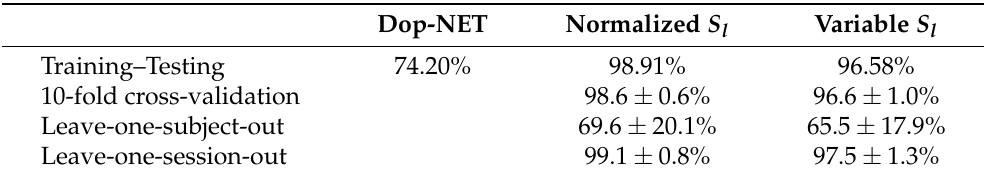
Table 3. Dop-NET results for an LSM with 960 neurons and C inp = 5, using SVM as a classifier. Lists of the results when using the specific training and test sets for comparison with [16], the 10-fold cross-validation, and the leave-one-subject-out and leave-one-session-out.